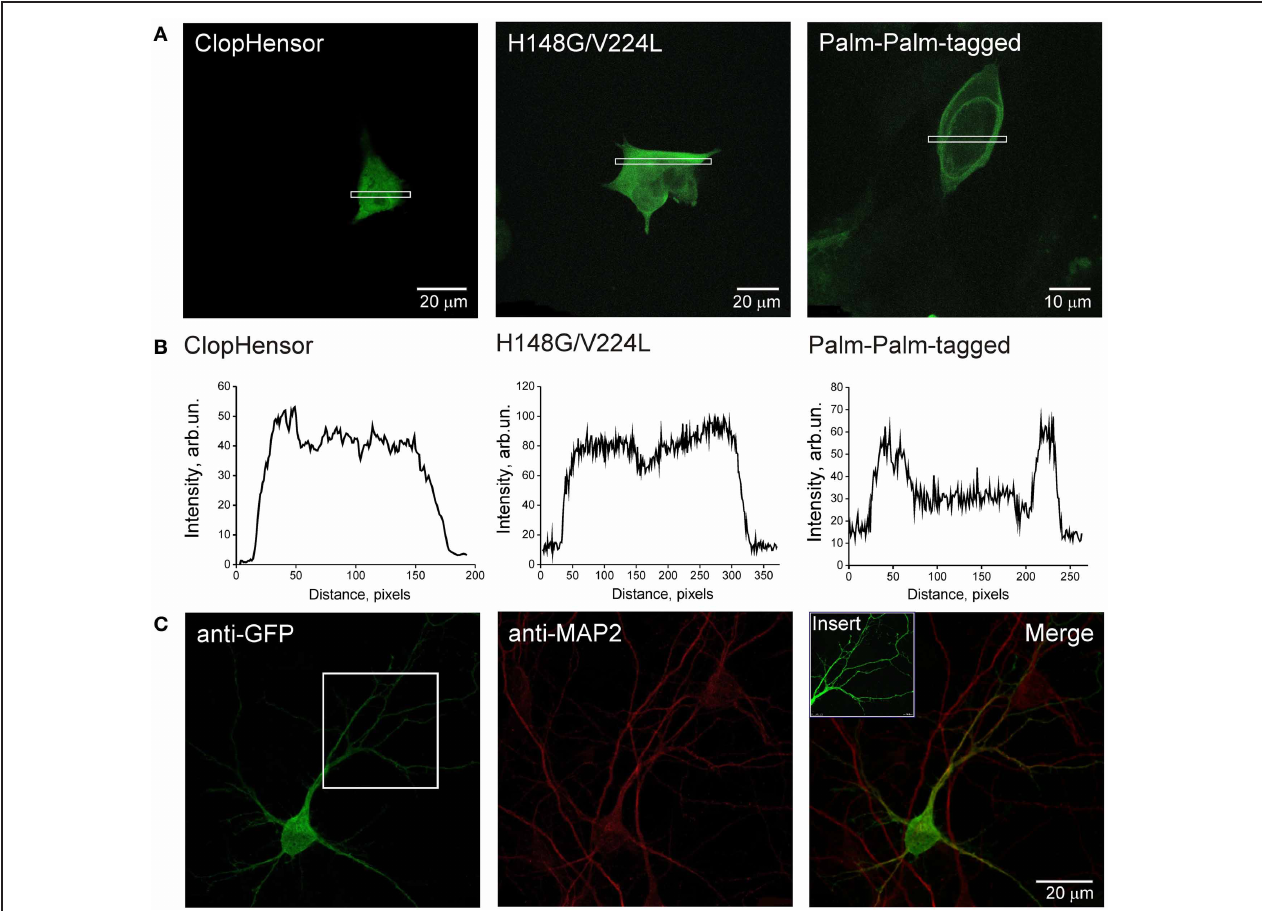
ClopHensor and H148G/V224L mutant and preferential membrane localization for PalmPalm-ClopHensor that is additionally confirmed by profiles of fluorescent signal distribution. (C) Confocal micrographs of ClopHensor expressed in a hippocampal neuron (DIV14). The probe spread well throughout the cell body and processes, thus providing a suitable tool for [Cl − ] i and pH i monitoring in different regions of